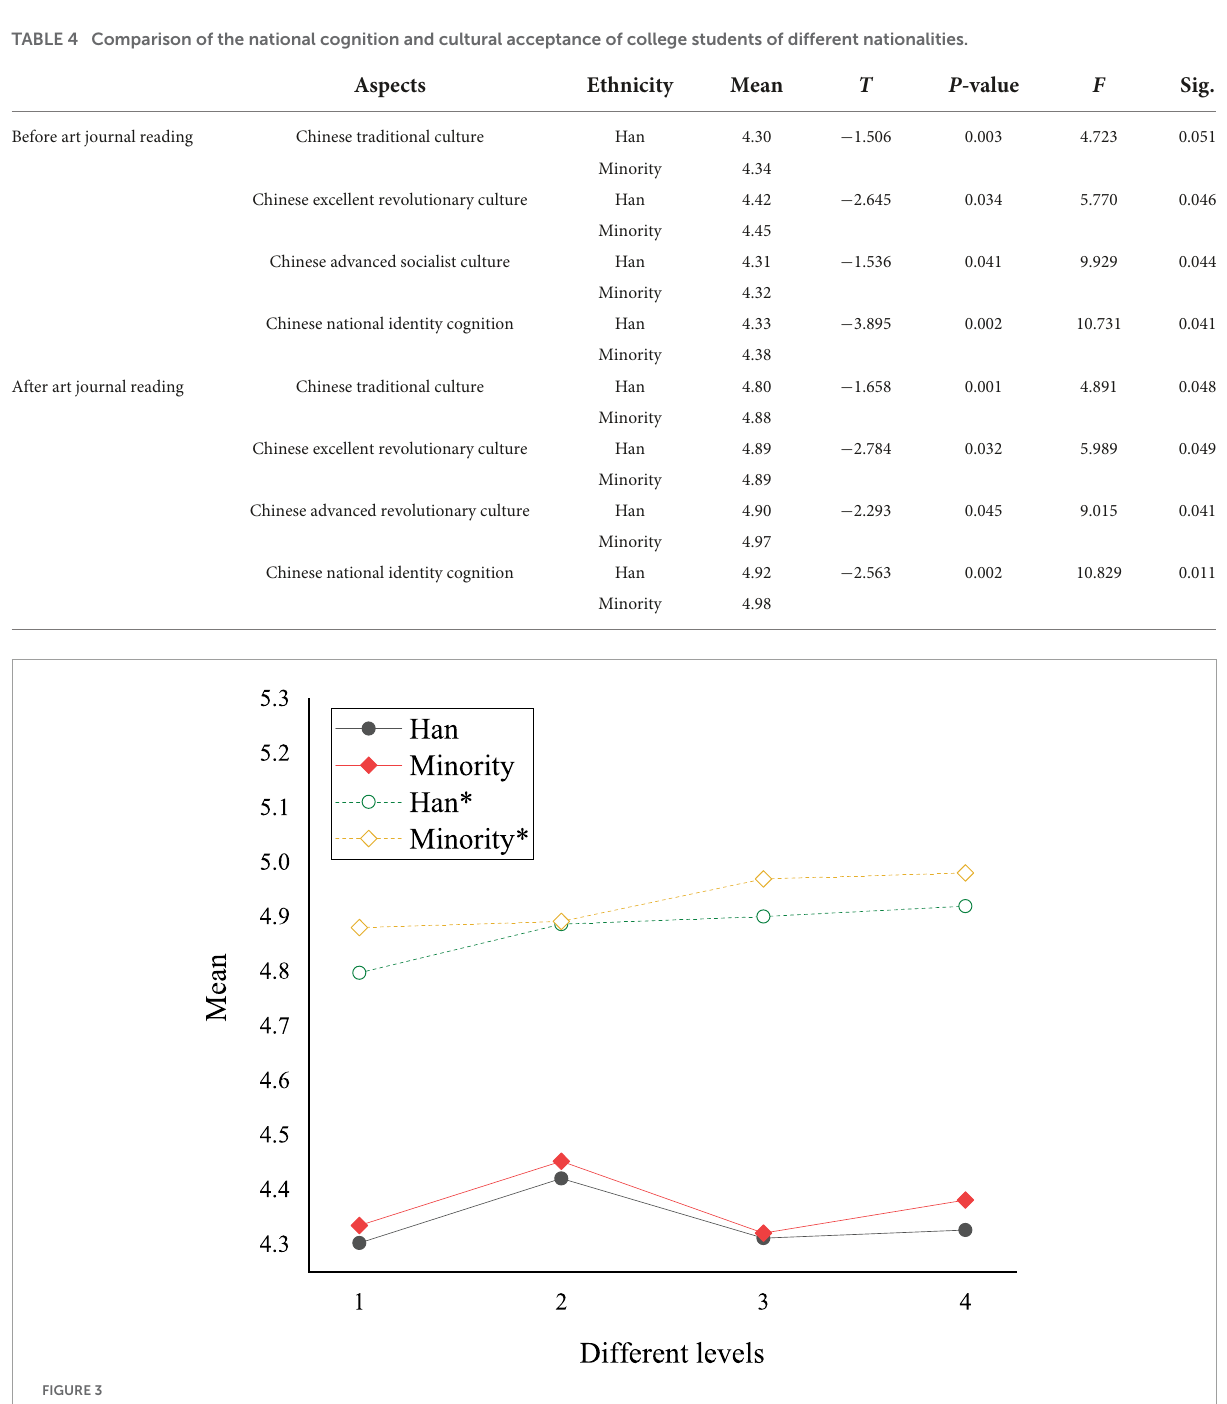
FIGURE3 Comparison of the national cognition and cultural acceptance of college students of different nationalities before and after reading art journals. * denotes post-test